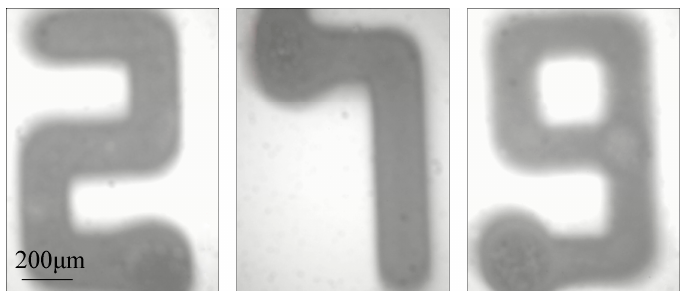
Figure 7. Optical images of Arabic number ‘2’, ‘7’, and ‘9’. The applied voltage, the flow rate of solution, the velocity of substrate, the distance between nozzle and collector and the deposition time were 1.5 kV, 50 μ L/h, 5 mm/s, 5 mm, and 15 s, respectively.